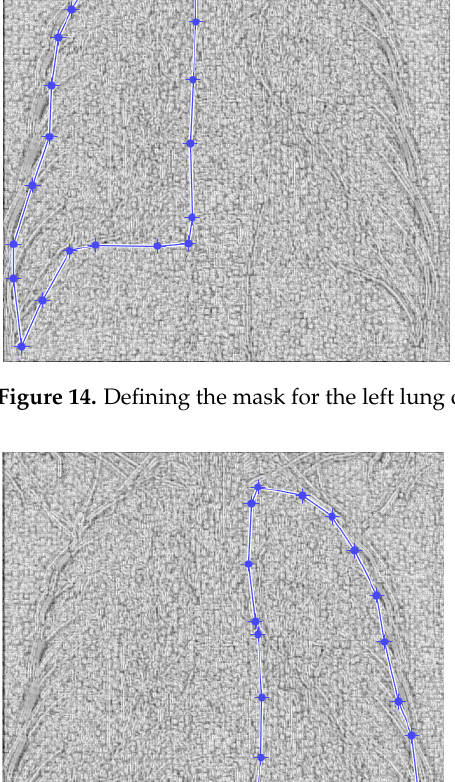
Table 3. Fractal indicators for the third patient .